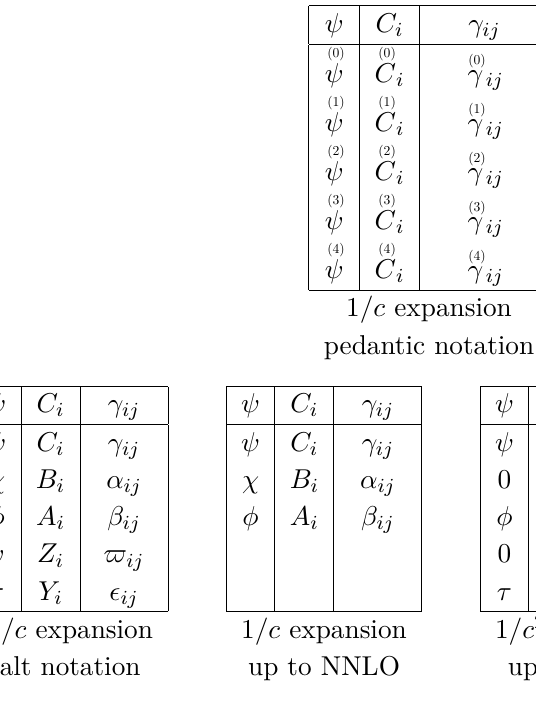
Table 2 . On the top all potentials/fields in the 1 /c expansion up to order c − 4 are listed in a precise but somewhat pedantic notation. On the left of the second line the same potentials are listed in an alternative notation. Second to left are those potentials featuring in the 1 /c expansion up to NNLO, while second to right are those potentials present in the truncation to the 1 /c 2 expansion up to NNLO. All the way on the right we list those potentials present in the PN expansion up to first Post-Newtonian order. On the far left the order at which these fields enter the 1 /c expansion of their relativistic counterparts is